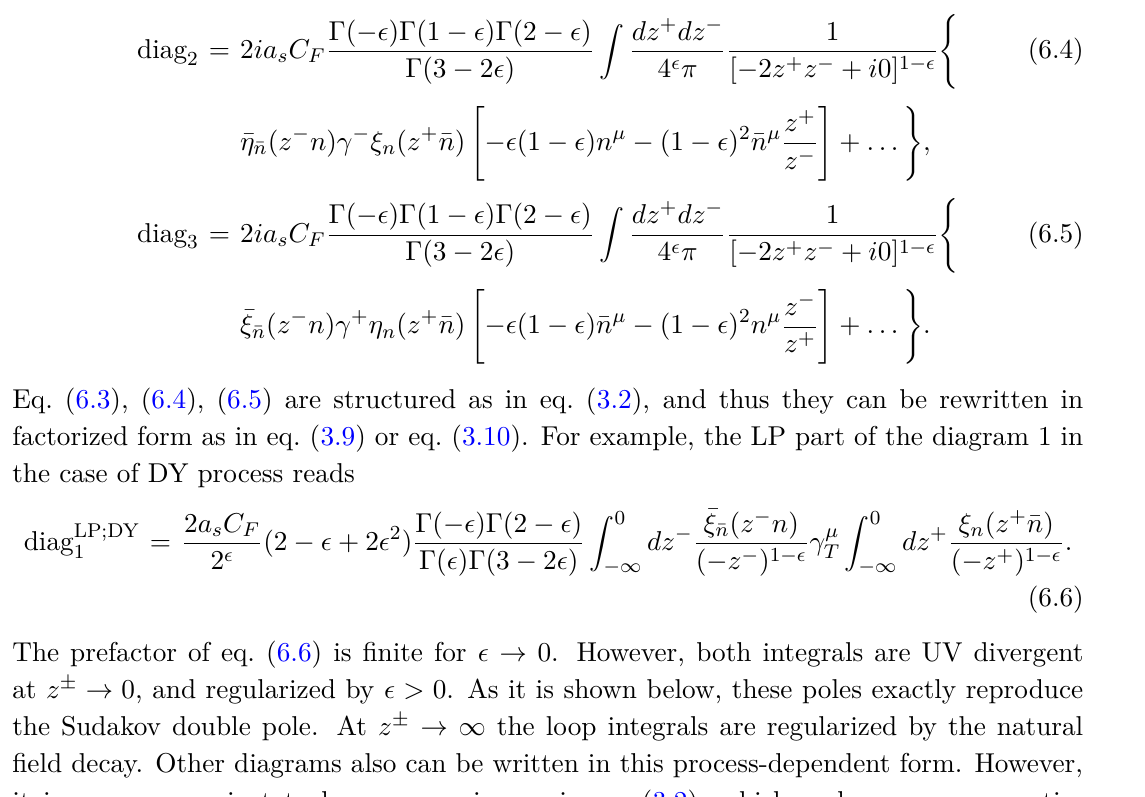
Figure 5 . The two-points diagrams contributing to the NLO of the effective operator. The diagram 1 contributes to LP, and the diagrams 2 & 3 to NLP. The diagrams with n ↔ ¯ n should be added. The blobs indicate the type of background field. The blue lines are the dynamical fields. and dots denote the higher-power terms. Similarly we compute the diagrams 2 and